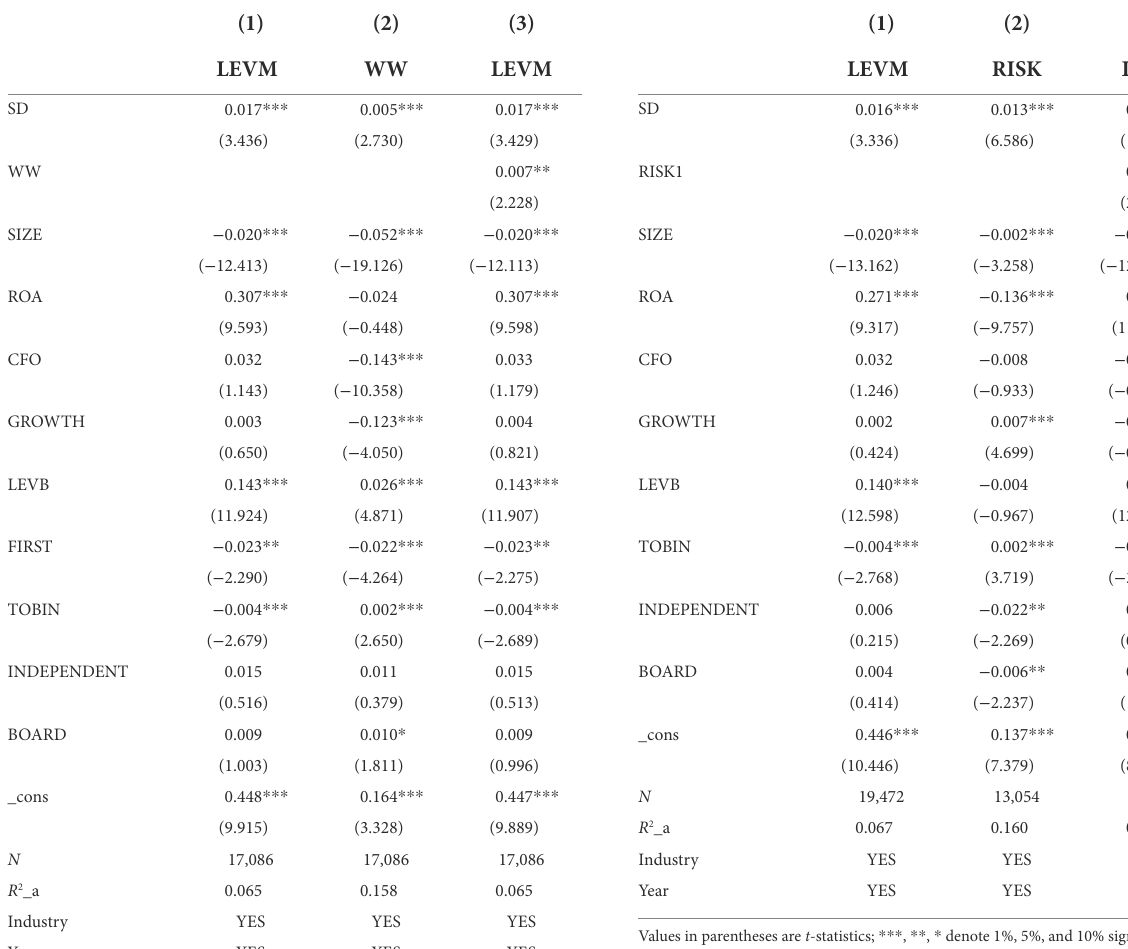
TABLE 8 Test of financing constraint mechanism. TABLE 9 Risk taking level mechanism